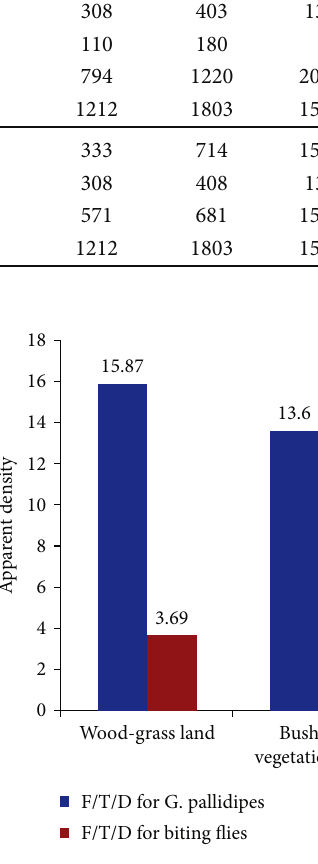
Table 2: Distribution and abundance of G. pallidipes and other biting fl ies in the study area. Variable